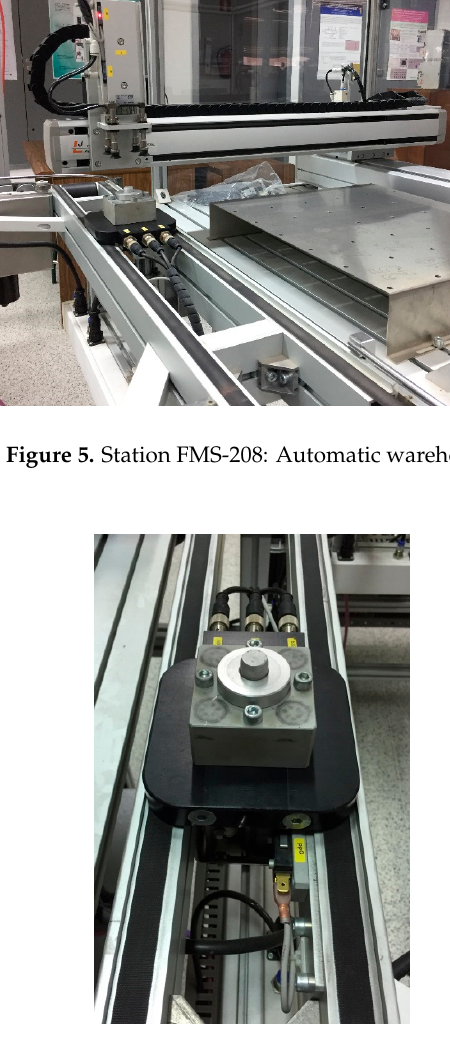
Figure 6. Transport pallet of the transfer system with a final piece.